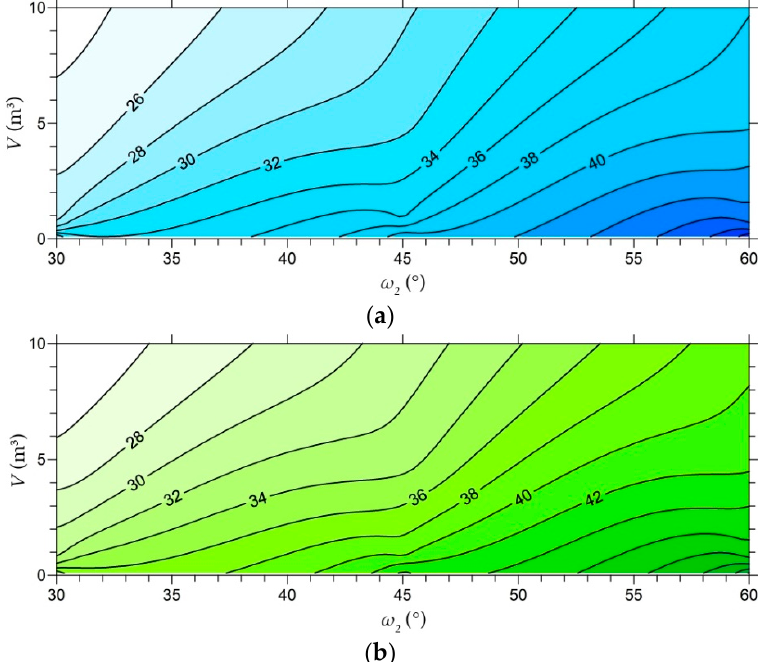
Figure 11. Resulting chart for the estimation of the energy angle φ p as a function of slope inclination and block volume. Contour black lines refer to the same energy angle conditions: ( a ) non-forested slope; ( b ) forested slope (400 trees/ha).